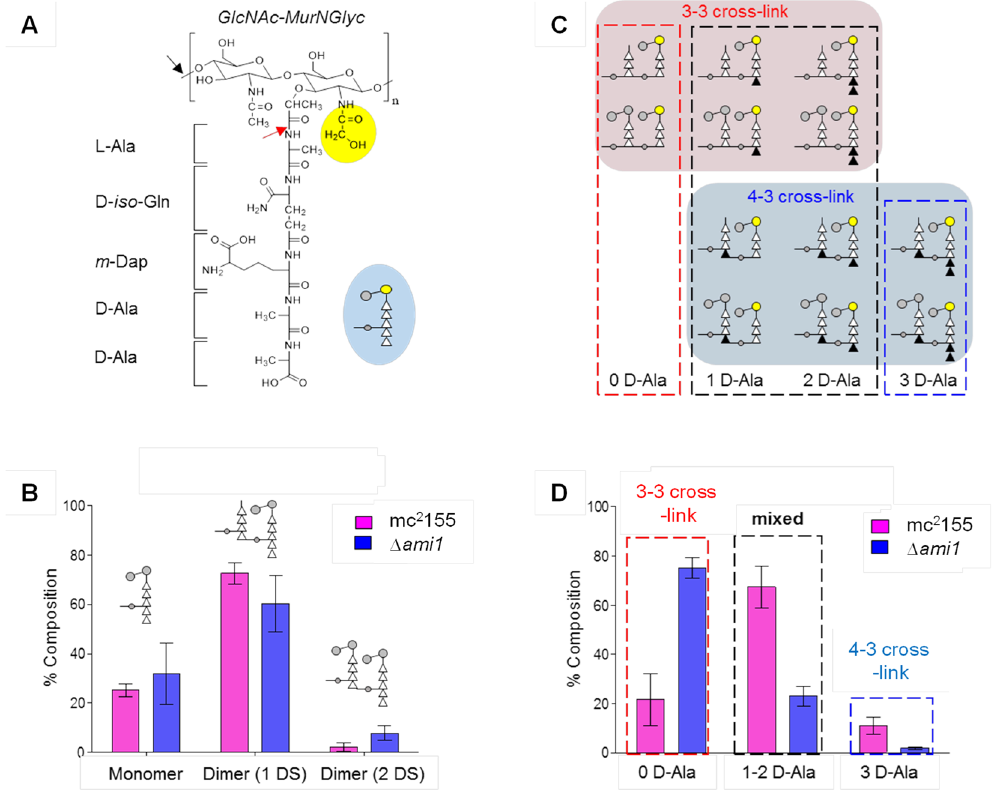
Figure 7. Compositional analysis of peptidoglycan from mc 2 155 and Δ ami1 mutant strains by LC-MS. ( A ) Chemical structure of the PG-repeat unit in M. smegmatis . The disaccharide, GlcNAc-MurNAc, is represented by grey circles, and glycosylated MurNAc as a yellow circle. A pentapeptide stem unit having a sequence L-Ala- D-iso-Gln- m -Dap-D-Ala-D-Ala is attached to the disaccharide. The side chain of m -Dap, which forms a cross- link with carbonyl carbon of D-Ala in the fourth position from neighbouring repeat unit stem, is shown as a small grey circle. Mutanolysin and the amidases cleave sites indicated by black and red arrows respectively. The blue inset shows the schematic representation of a muropeptide. ( B ) All identified muropeptide species from mutanolysin-digested PG of M. smegmatis , independent of glycolylation, amidation, PG-stem modifications and cross-linking types, were classified based on the number of repeat disaccharide units. The isolated muropeptide fragments from wild type M. smegmatis were dominated by PG monomers and dimers, indicating low PG cross-linking, which was further reduced in the Δ ami1 mutant, as evidenced by increased monomers and a decrease in dimers. ( C ) Schematic representation of the chemical structures of PG dimers with variation in stem peptide length. The total number of D-Ala (black triangle) is used to determine the proportion of 3-3 and 4-3 cross-linked dimers. ( D ) Dimer composition of mc 2 155 and Δ ami1 mutant strains. In mc 2 155, both 3-3 and 4-3 cross-linked dimers are observed. In contrast, 3-3 cross-linked dimers are predominantly found in Δ ami1 strain. All errors bars represent 95% confidence interval (n =